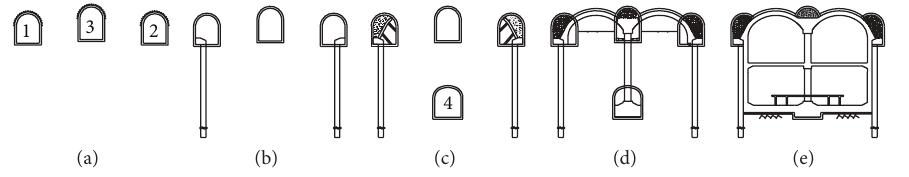
Figure 3: PBA excavation method adopted in the Zhongjie subway